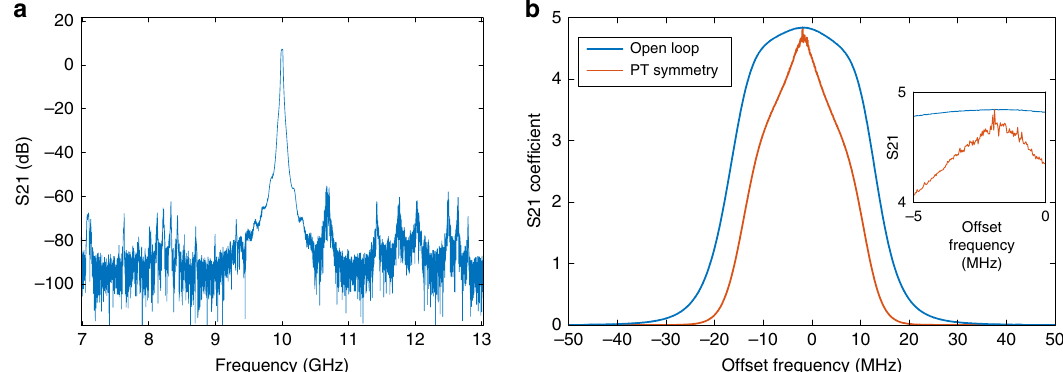
Fig. 3 The open-loop gain spectrum. a Gain spectrum measurement by a VNA connected at the gain probing point; b Zoom-in view of the gain spectrum at 10 GHz (blue) and the calculated gain pro fi le (red) after gain contrast enhancement with PT symmetry. Inset: zoom-in view of the enhanced